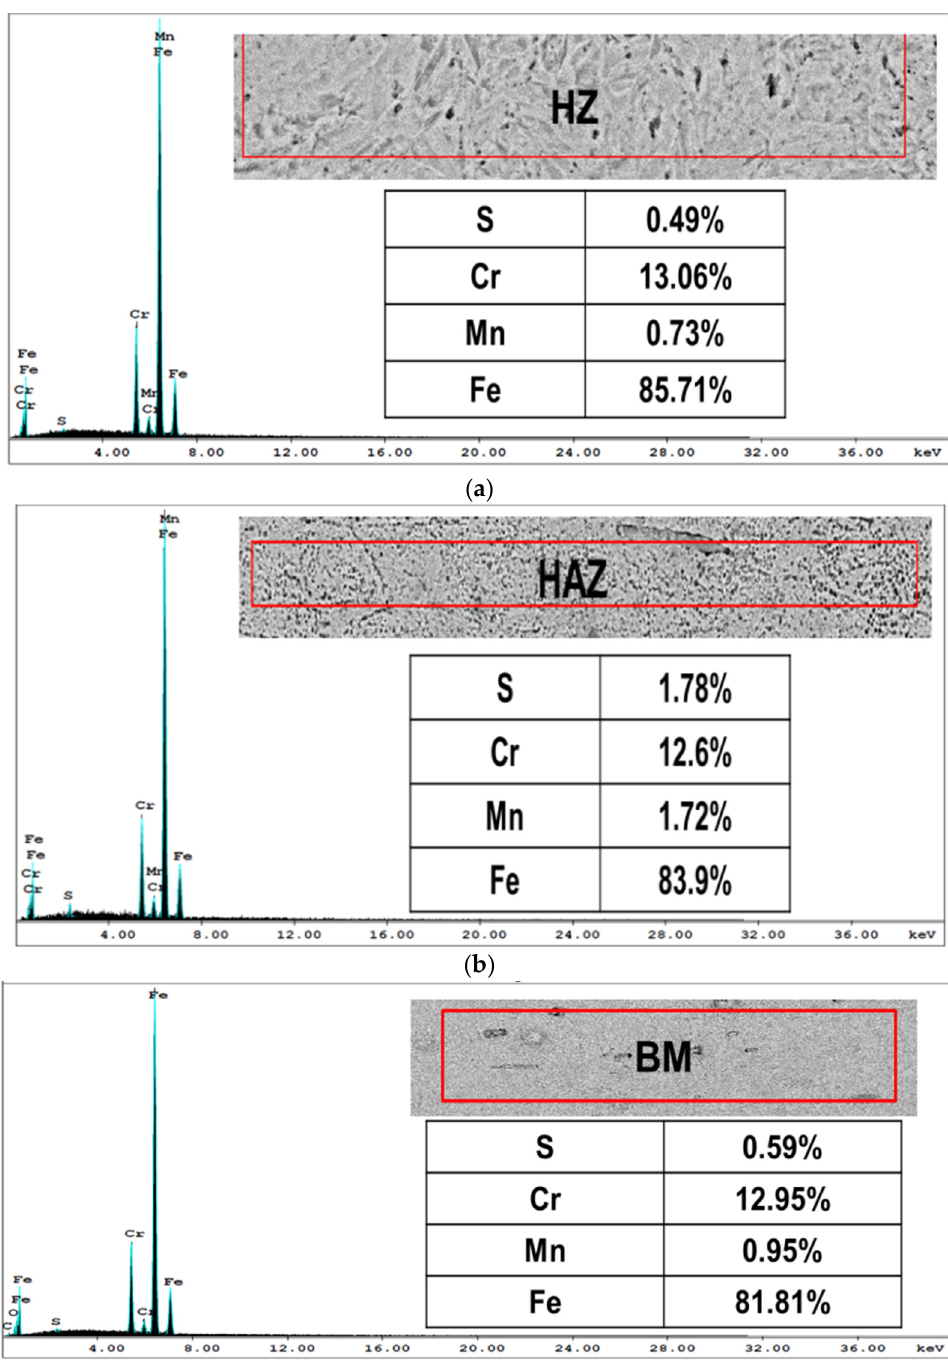
Figure 6. EDX analysis of the LHT P-1-0.5 sample: ( a ) hardened zone (HZ); ( b ) heat affected zone (HAZ); and ( c ) base metal